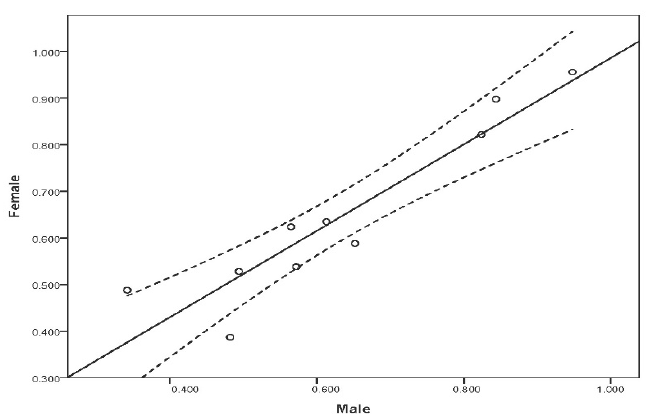
Table 1. RMNPI and TMQHPI in male and female groups.